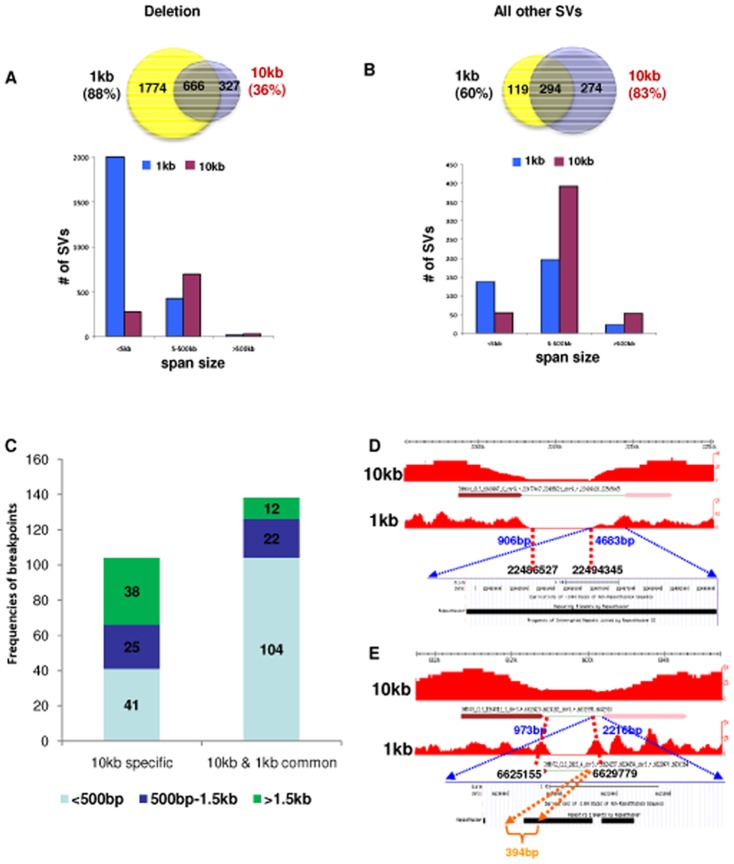
Comparison of SVs identified by 1 kb and 10 kb libraries in the three genomes.(A–B) Number of SVs identified in 1 kb libraries compared to the number of SVs identified in 10 kb libraries. Top, Venn diagrams showing the respective numbers of SVs in each library type and the overlap of SVs. Percentages in parentheses represent SVs identified by 1 kb or 10 kb libraries in all three genomes. Bottom, number of SVs (y-axis) of the indicated SV categories was shown for the specific span sizes (x-axis). (C) Breakpoints confirmed by PCR and Sanger sequencing and their resolution (defined as the distance in bp between the predicted and actual breakpoints). (D) A 10 kb library specific deletion in MCF-7. The genomic PCR and Sanger sequencing confirmed left and right breakpoints are chr9:22,486,527 and chr9:22,494,345, respectively (hg18). The resolution of the left and right sides of the deletion are 906 bp and 4,683 bp, respectively. Repetitive sequence which does not allow unambiguous mapping covers the entire 4,683 bp region. The repetitive sequence could not be spanned by the 1 kb library preventing the identification of this deletion. (E) A deletion in MCF-7 identified by both 10 kb and 1 kb libraries. The left and right breakpoints confirmed by genomic PCR and Sanger sequencing are at chr3:6,625,155 and chr3:6,629,779, respectively (hg18). Based on the 10 kb library predicted breakpoints, the resolution on the left and right sides of the deletion are 973 bp and 2,216 bp, respectively. The tags of the 1 kb library mapped to the gap (in orange) between the repetitive sequences and allowed the identification of this deletion.